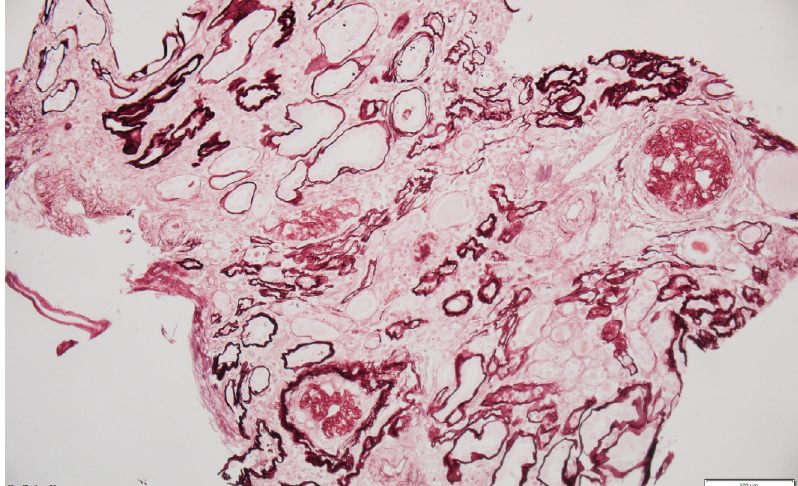
Figure 2. Light microscopy with periodic acid-silver methenamine staining: interstitial enlargement with tubular atrophy and sclerotic